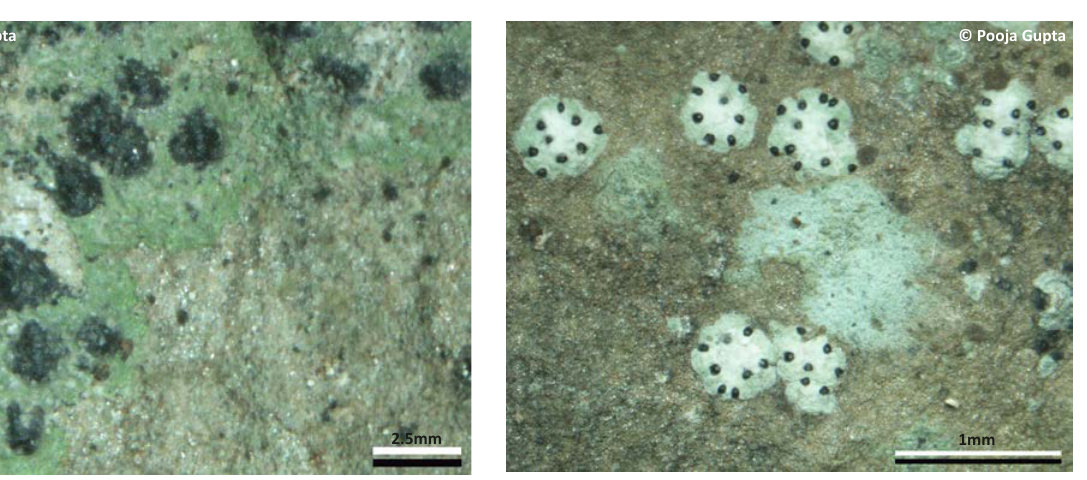
Image 9. Strigula smaragdula Fr. Image 10. Strigula subelegans